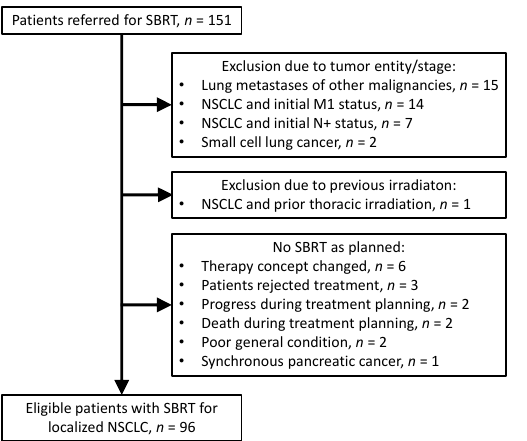
Figure 1. Flow chart. The chart informs about the selection of the 96 patients for outcome analysis. SBRT: stereotactic body radiation therapy; NSCLC: non-small cell lung cancer. 2.2. Stereotactic Body Radiation Therapy Patients received four-dimensional computed tomography (CT). A respiration belt was used to detect the breathing excursions. Patients were immobilized in supine position with customized positioning devices. In 28 patients, the MacroMedics Omniboard TM system was applied. We used the CT scanners Philips Gemini TF TOF 16 ( n = 24 patients), Philips Ingenuity Flex ( n = 3 patients), and Philips Brilliance Big Bore ( n = 69 patients). The scans were acquired with a slice thickness of 2 mm ( n = 4 patients), 3 mm ( n = 90 patients), or 5 mm ( n = 2 patients). The gross tumor volume was contoured in each of the respiratory phases. The internal target volume was generated by combining the gross tumor volumes of the respiratory phases. The margins for the planning target volume were set on an individual basis by the treating physician (range, 0.3 cm–1.0 cm). Treatment plans were generated using the treatment planning system Eclipse (Varian Medical Systems, Palo Alto, CA, USA). The Eclipse TM versions 10.0 (from December 2012), 11.1 (from October 2013), 13.5 (from October 2014), and 15.6 (from June 2020) were used. The dose calculation algorithms were Acuros ( n = 86 patients) and AAA ( n = 10 patients). The dose was prescribed to the 80% isodose ( n = 78 patients) or to the 95% isodose ( n = 18 patients). SBRT was delivered with a linear accelerator (Varian Clinac 2300 CD) and daily cone beam CT imaging. 2.3. Statistical Methods First, the characteristics of pretreatment assessment (patients with SBRT in the pre- COVID era vs. patients in the COVID era) were compared. Second, we used univariable Cox regression analysis to test for an influence of pretreatment diagnostic assessment on outcomes. The survival times were calculated from the day of the start of SBRT. We analyzed overall survival (OS; event: patient death due to any cause), progression-free survival (PFS, events: patient death, tumor progression), locoregional progression-free